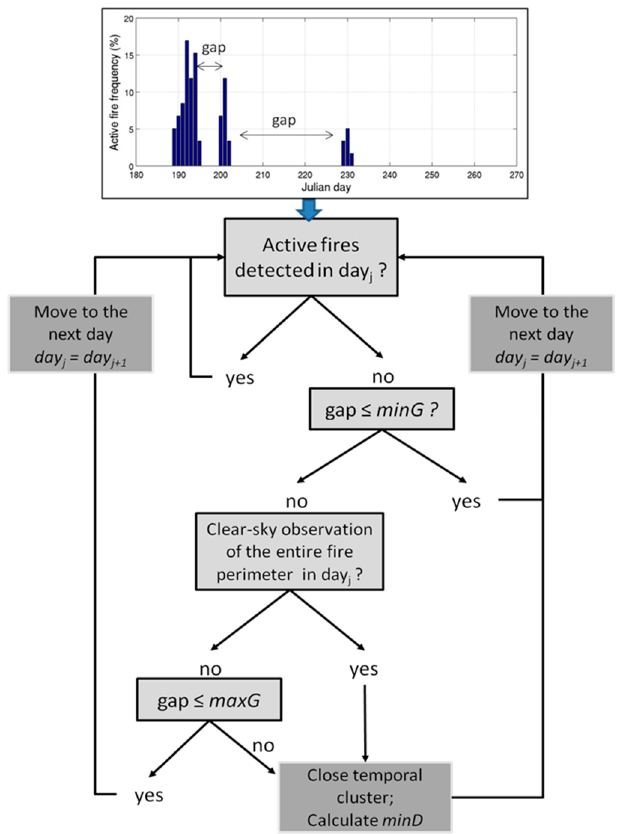
Figure 2. Methodological flow chart of the temporally constrained clustering algorithm used in the estimation of fire start/end dates.